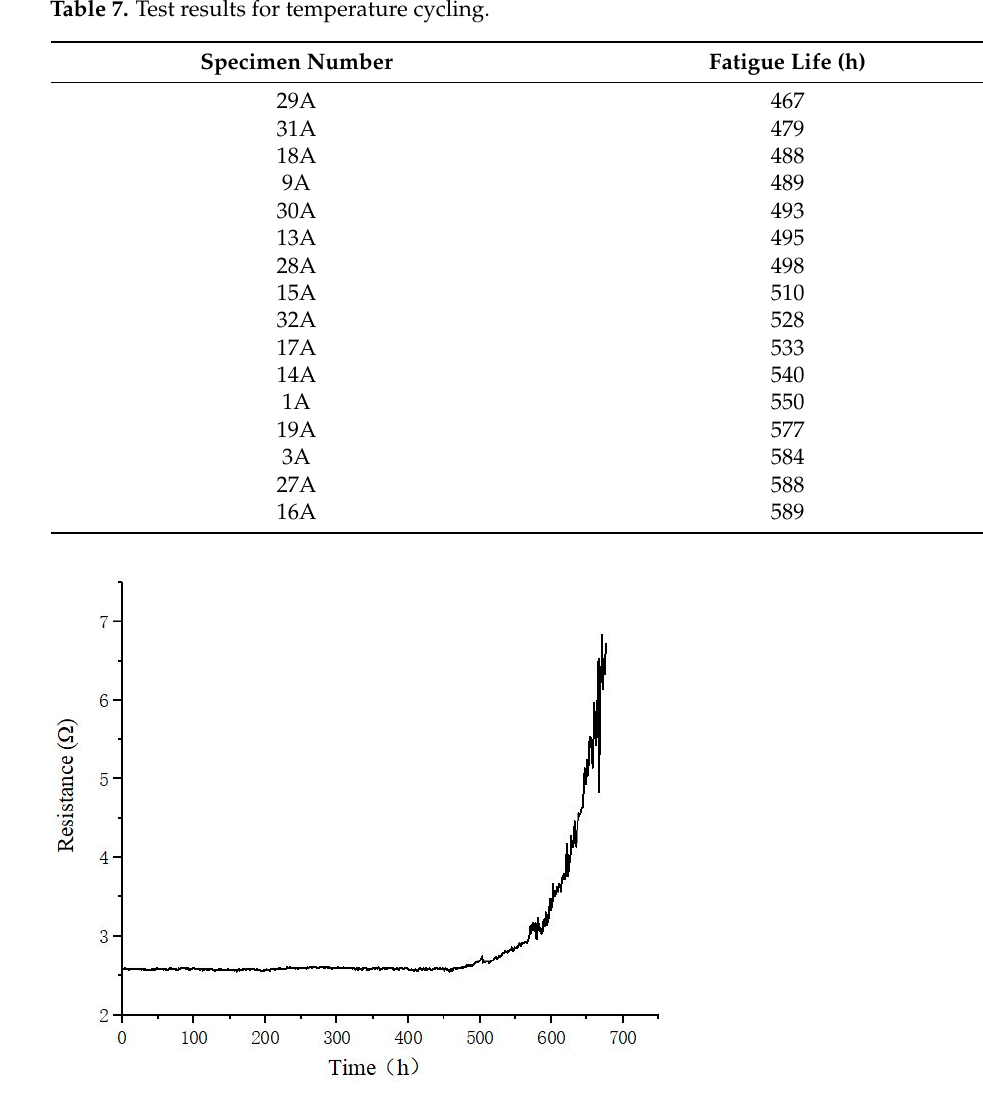
Figure 12. The resistance of daisy chain circuit specimen 16A as the function of time for the temperature cycling tests. Table 7. Test results for temperature cycling.